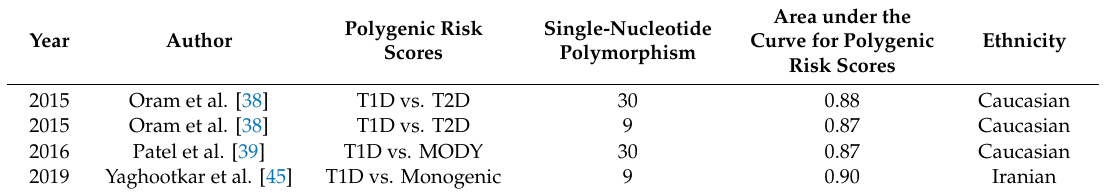
Table 5. Comparison of accuracy of T1D PRS to discriminate diabetes subtypes, assessed by the